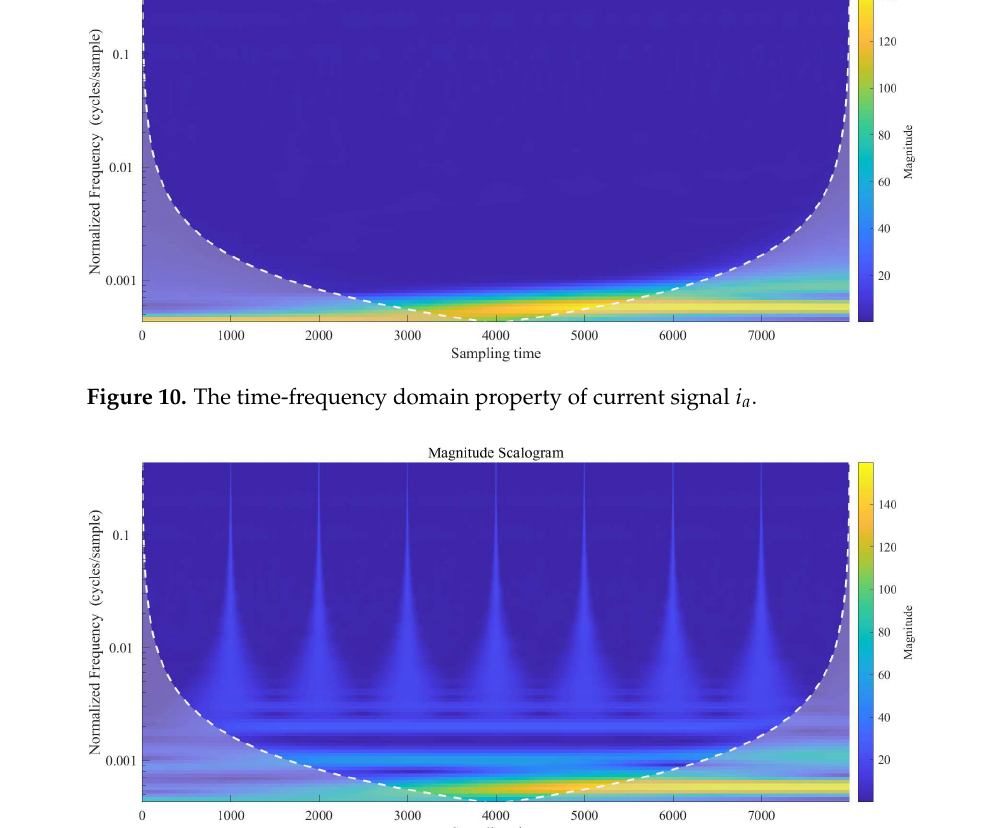
Figure 11. The time-frequency domain property of current signal i a with the normal trend removed.